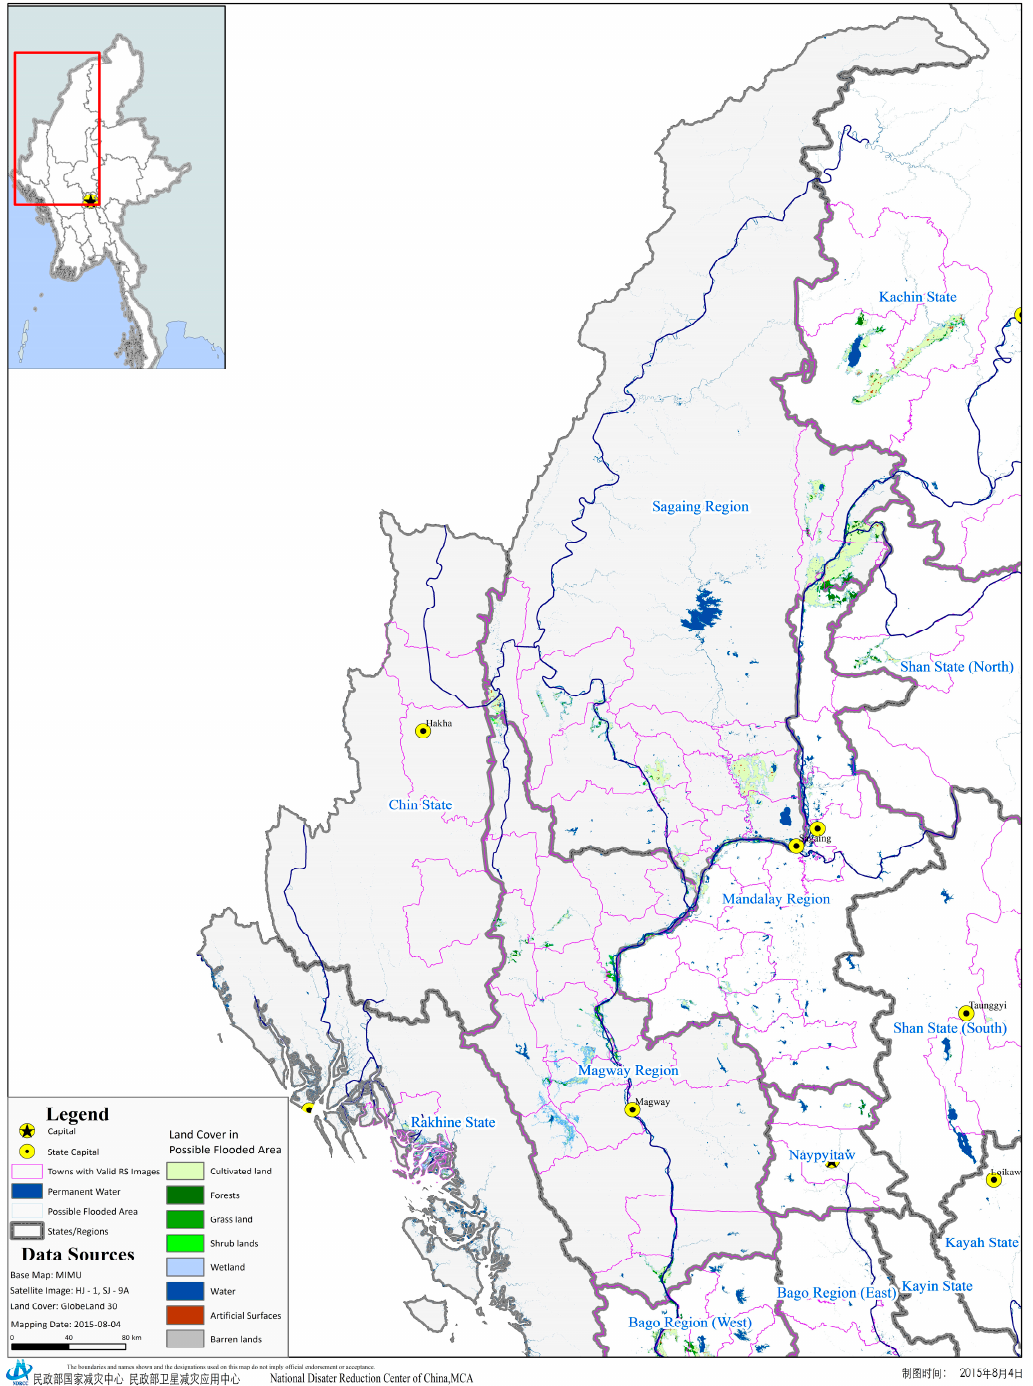
Figure 7. Land cover of the Flooded Areas